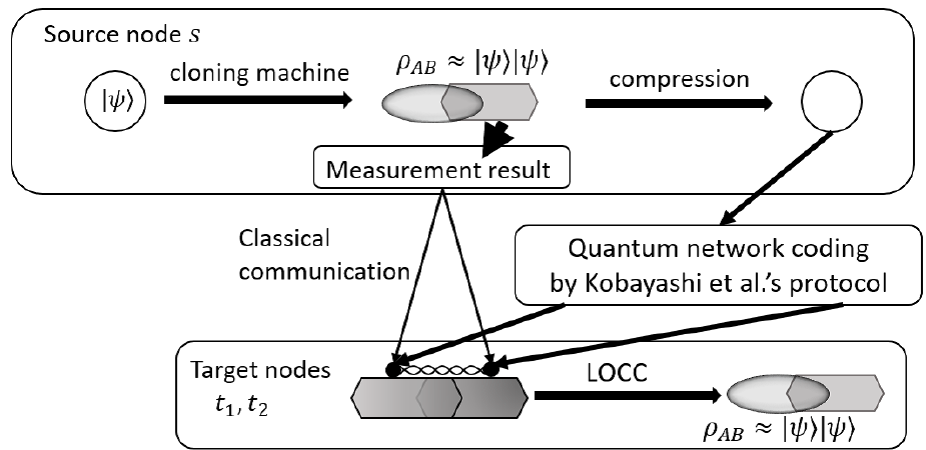
Figure 2. Schematic diagram of a protocol for multicasting asymmetric optimal UQCs from one source node to two target nodes. The asymmetric optimal cloning protocol for the input state | ψ (cid:105) is implemented at the source node. The resulting state is compressed into a d -dimensional system and transmitted to the two target nodes using the quantum multicast network coding protocol of Kobayashi et al. [44]. Finally, the asymmetric optimal clones of the input state are reconstructed by LOCC on target nodes with the help of a small amount of